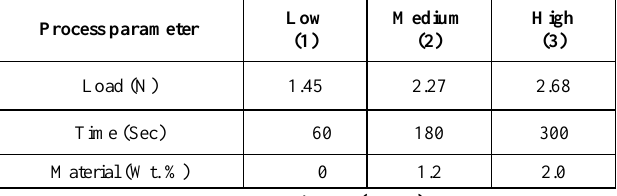
Table 4: Process parameters and their values at different levels.